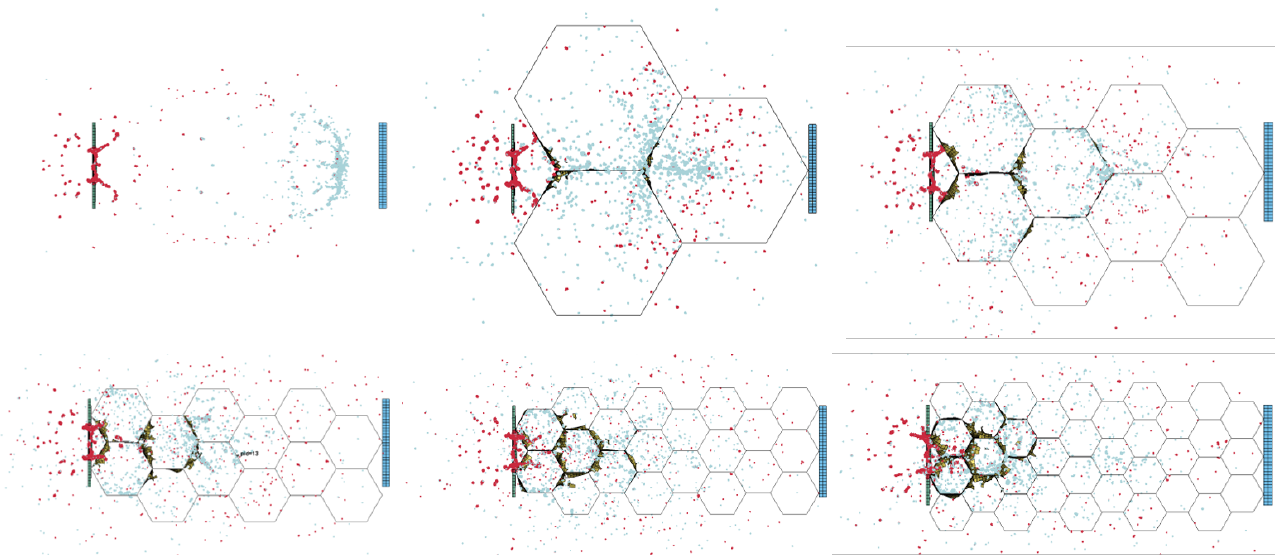
Figure 14. Simulation progress at t = 16.2 µ s for an increasing number of cells across the width of honeycomb core for model C-0 ( top left ) to model C-10 ( bottom right